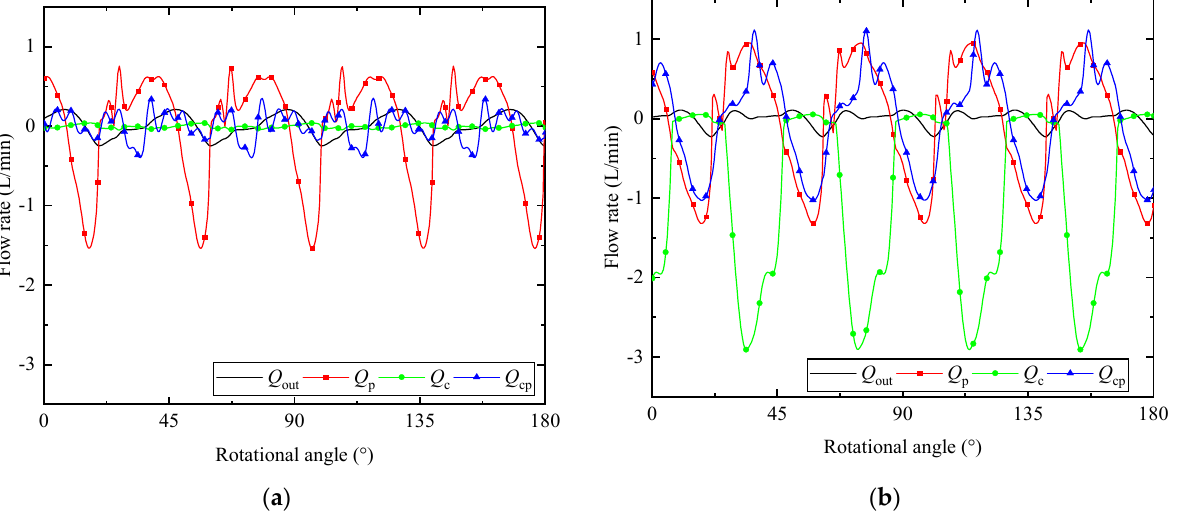
Figure 12. Flow rates from different chambers: ( a ) without APC; ( b ) with APC. The pressure ripple reduction can be achieved with the active pressure controller.